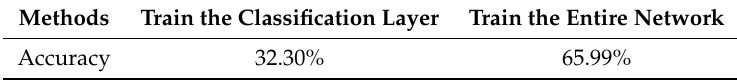
Figure 4. Performance comparison between training the entire network and training only the classification layer. The classification method is signal rearrangement method (SRM), the model used is Resnet18, and the dataset is Sig1024. Table 2. Overall classification accuracy of training the entire network and training only the classification layer. The classification method is SRM, the model used is Resnet18, and the dataset is Sig1024.